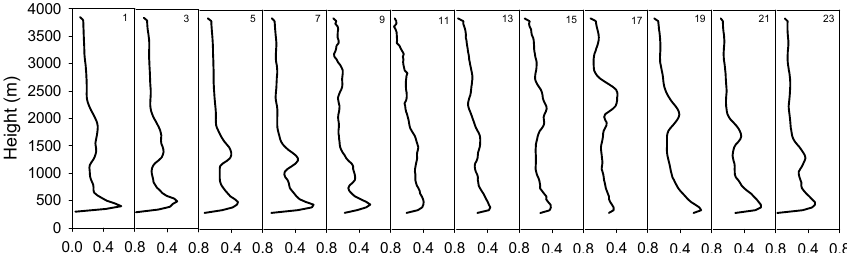
Fig. 2. Vertical profiles of the extinction coefficients corresponding to 16 June 2004 for specific hours of the